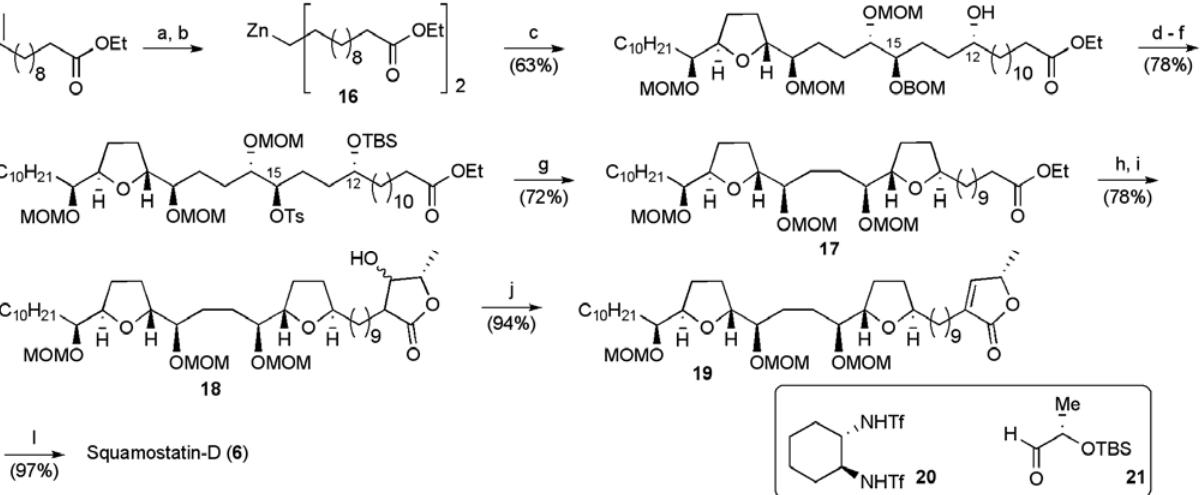
Scheme 3. Total synthesis of squamostatin-D ( 6 ).